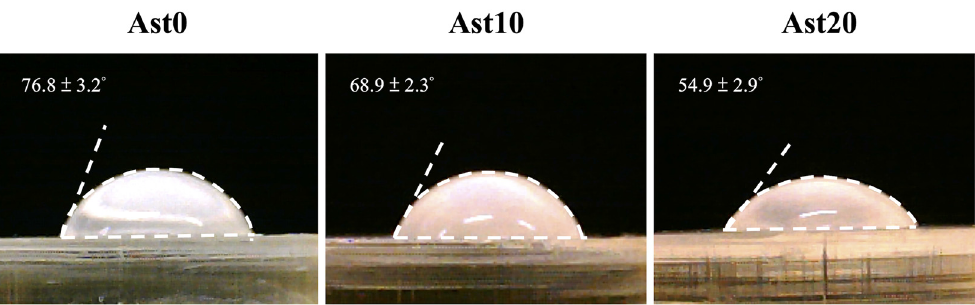
Figure 2. The water contact angle in Ast0 (0 µM), Ast10 (10 µM), and Ast20 (20 µM)